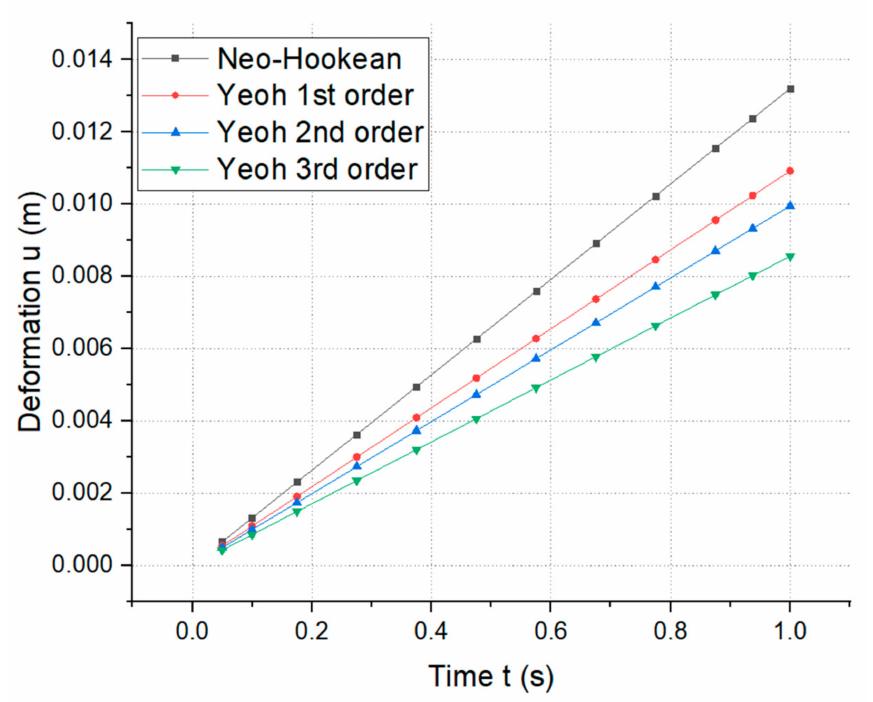
Figure 10. Variation of the normal deformation according to crack time in the hyperelastic material